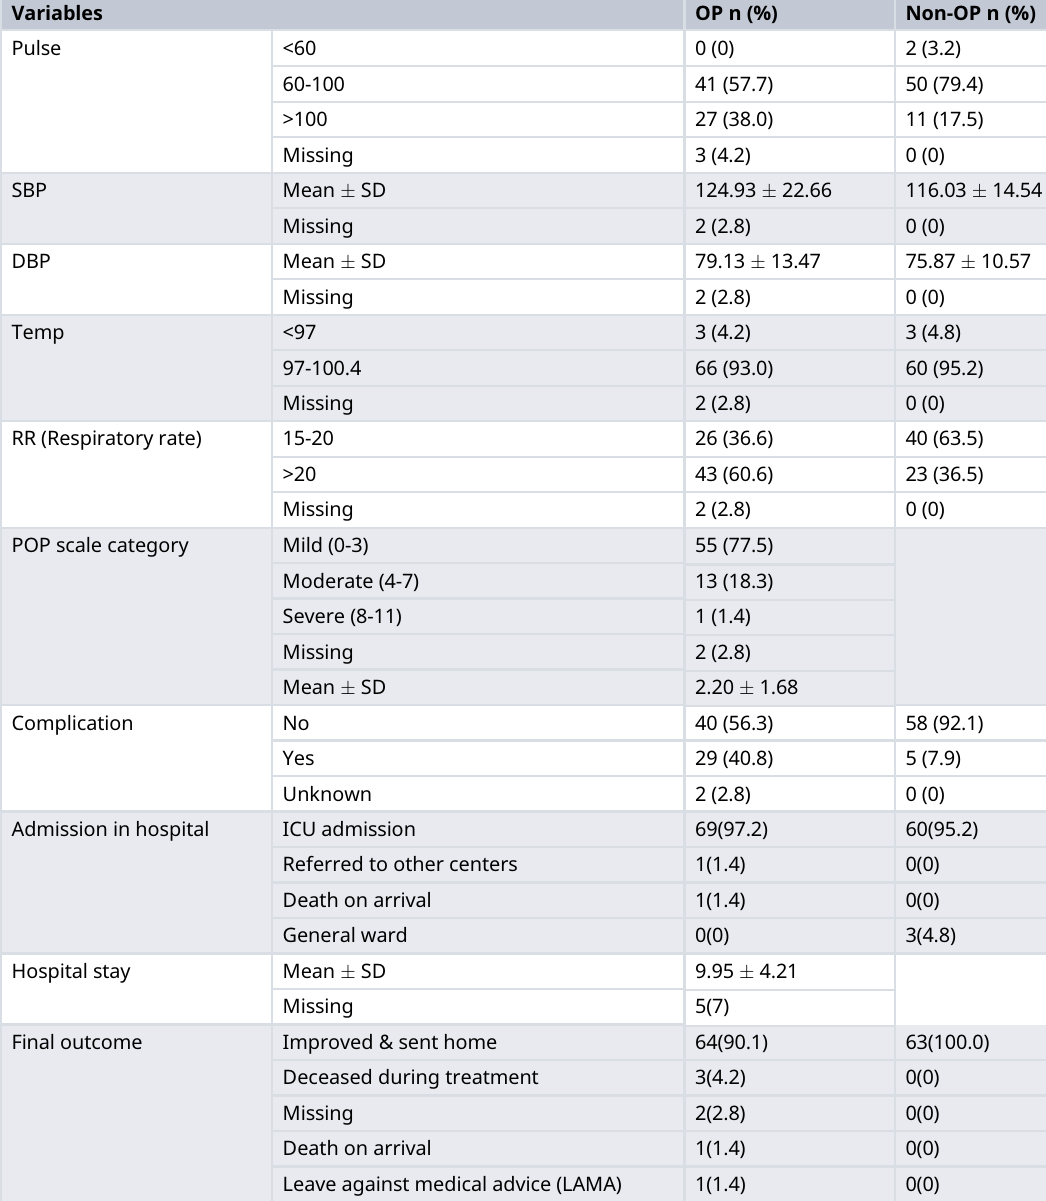
Table 2. Vitals at presentation and outcome of patients of OP-group versus Non-OP-group.